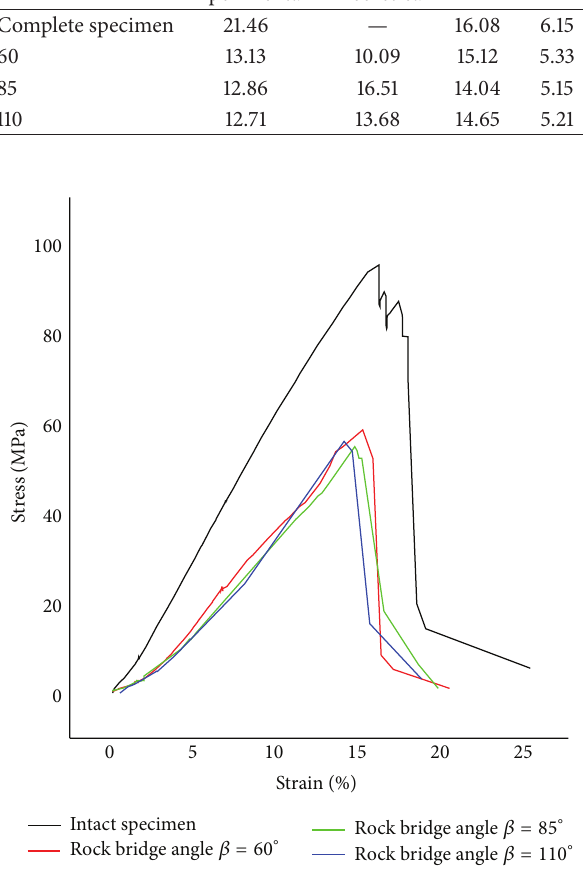
Figure 7: Stress and strain curves of samples with preexisting cracks of different bridge